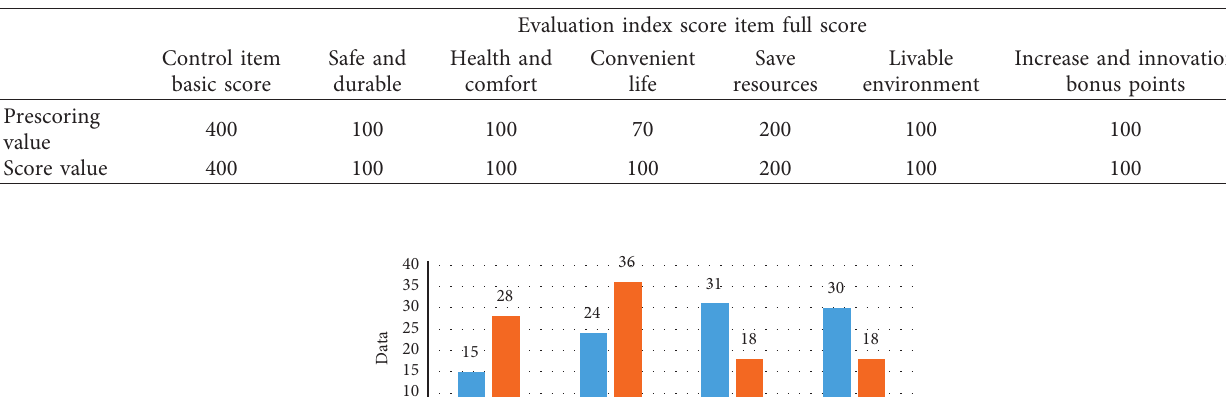
Table 3: Various indicators of green building.